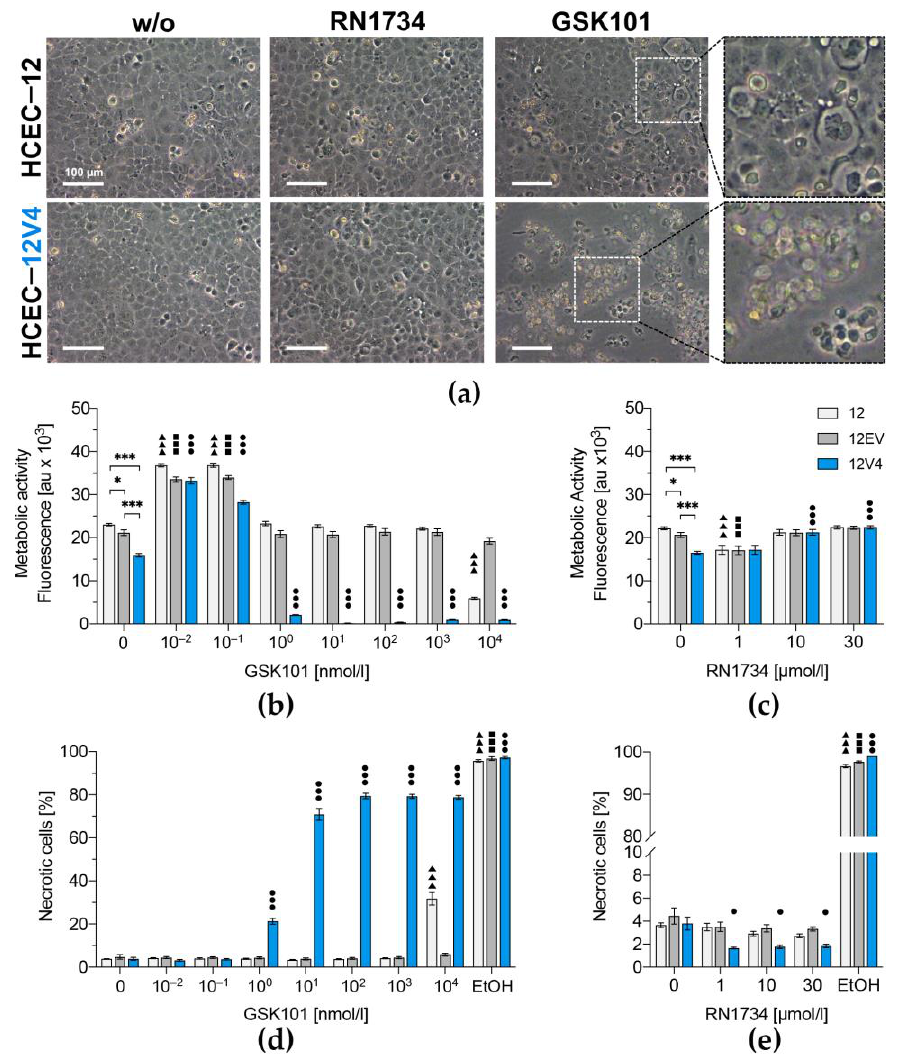
Figure 5. Monitoring of TRPV4-mediated cell death in HCEC-12 (12) and its derivatives, 12EV and 12V4. Morphology of HCEC-12- and HA-TRPV4-transduced HCEC-12 ( a ) either untreated ( left ) or treated with the TRPV4 antagonist RN1734 ( middle ) or the TRPV4 agonist GSK101 ( right ). Differential interference contrast (DIC) micrographs; scale bar 100 µm. Metabolic activity of GSK101- ( b ) or RN1734- ( c ) treated cells were analyzed by resazurin conversion assay. Cells were treated with GSK101 ( d ) or RN1734 ( e ), and membrane integrity was quantified by flow cytometry after vital staining with SYTOX Green to assess cell death. Triangles ( ▲ ) represent statistically significant differences compared to the untreated control sample, HCEC-12 (12); squares ( ◼ ) represent statistically significant differences compared to untreated HCEC-12EV (12EV); circles (●) represent statistically significant differences compared to untreated HCEC-12V4 (12V4) and asterisks (*) represent statistically significant differences between the untreated cell populations. Data are presented as the means ± SEM of n = 36 from four independent experiments ( b , c ) or n = 16 from two independent experiments ( d , e ). * p < 0.01, ** p < 0.001 and *** p = < 0.0001, one-way ANOVA with Tukey’s multiple comparisons test.